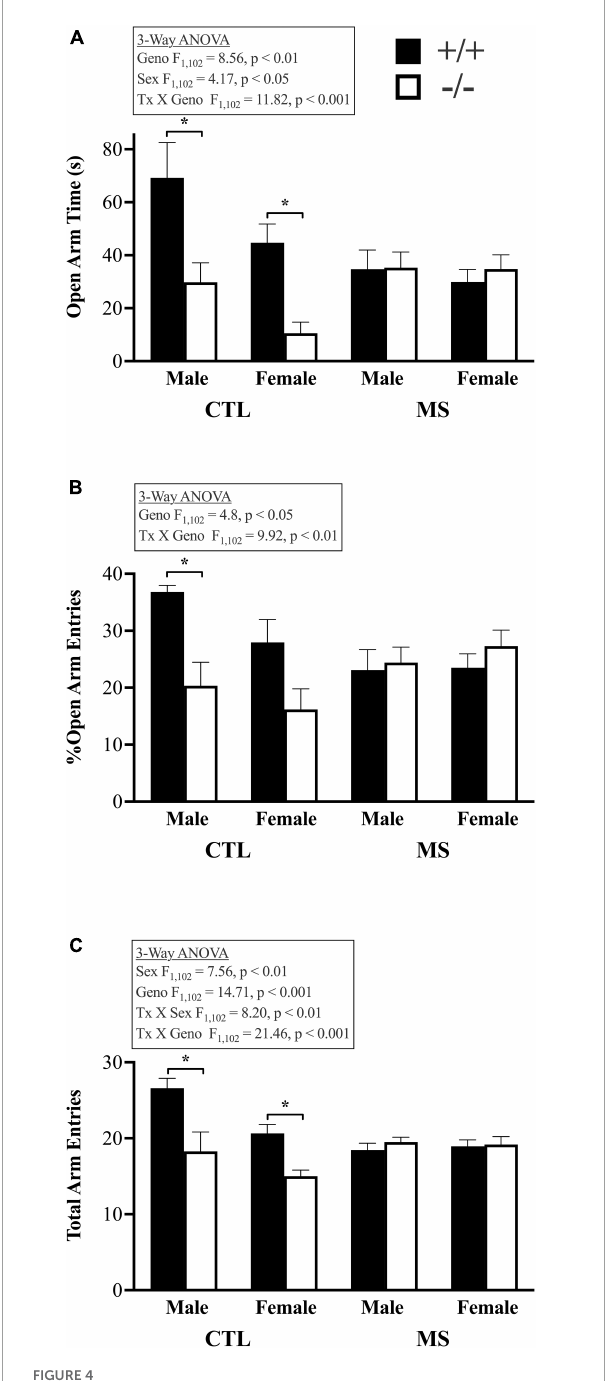
FIGURE4 Behavior assessed in the elevated plus maze in adult, male and female, wildtype (+/+) and β -E deficient mice ( − / − ) either raised normally or maternally separated between PND 5–18. (A) Shows more anxiety-like behavior (reduced time spent in the open arms of the maze) in β -E deficient mice than controls when raised in standard conditions, but increased anxiety, leading to a loss of group differences, in wildtype mice following maternal separation. This pattern was also evident in the percentage of entries into open arms (B) . However, normally raised β -E deficient mice were less active than controls as shown in panel (C) . Bars represent group means and SEM; the number of subjects per group ranged from 7 to 11, please see Table 1 for details. All significant group differences are highlighted in the associated text and described fully in the results; asterisks highlight significant post hoc